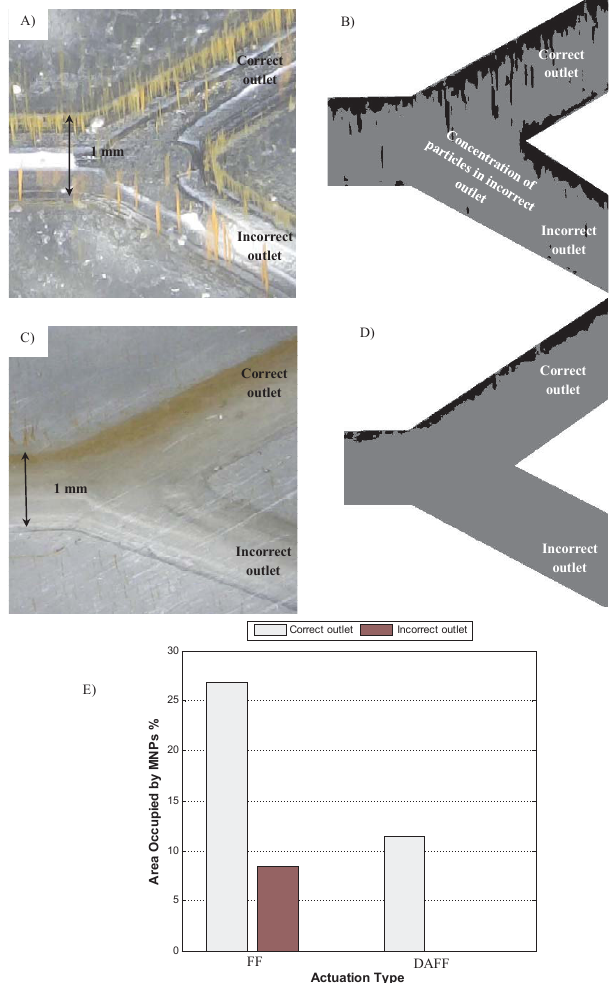
Figure 8. Video image analysis of the steering performance of a Y-shaped bifurcation. ( A ) Raw image for a field function (FF) of 6 A and 0.5 Hz. ( B ) Combined images obtained from averaging several hundred frames (6 A and 0.5 Hz). ( C ) Raw image under discontinuous asymmetrical field function (DAFF) of 6 A, 0.14 Hz and α = 0.16. ( D ) Combined images obtained from averaging several hundred frames (6 A, 0.14 Hz and α = 0.16). ( E ) The percentage of accumulated nanoparticles (NPs) in the correct and incorrect outlets under FF and